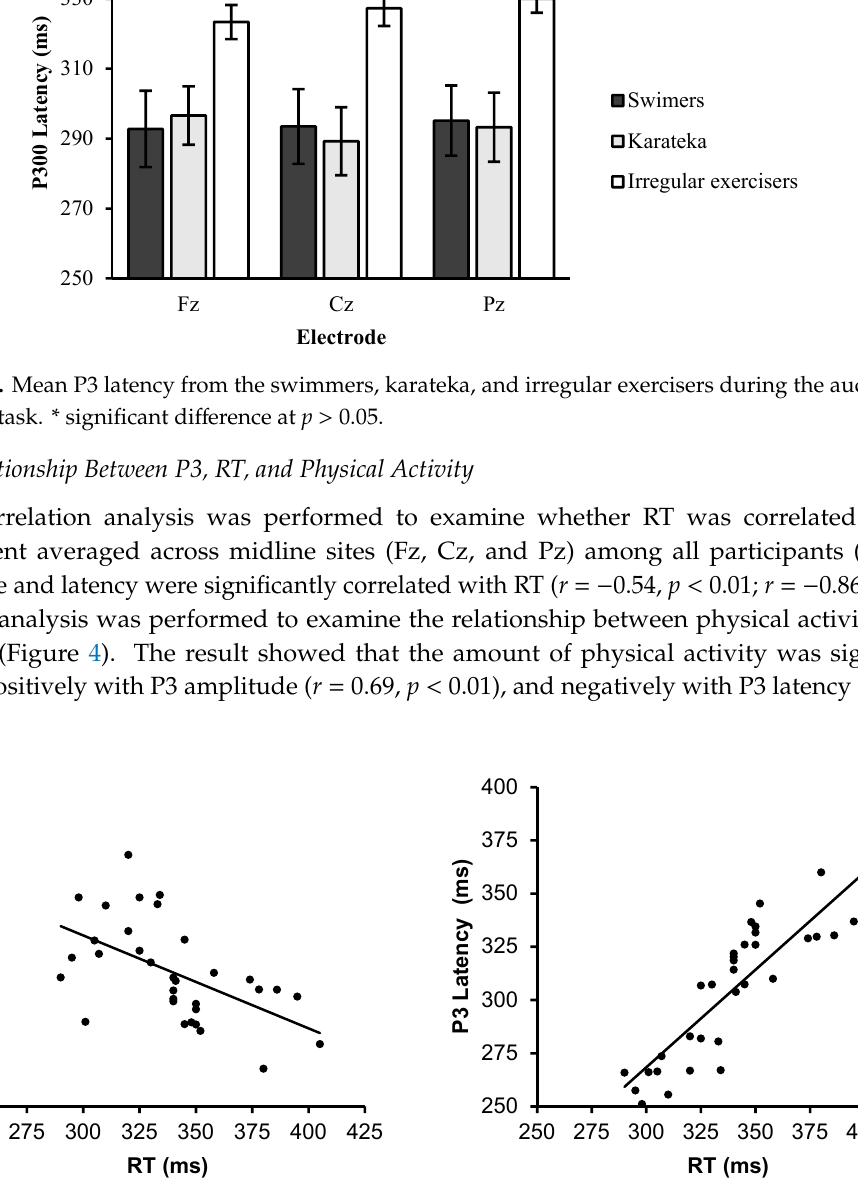
Figure 3. Scattergrams and correlation coefficients of P3 amplitude (left) and latency (right) from the averaged Fz, Cz, and Pz sites with the reaction time (RT).